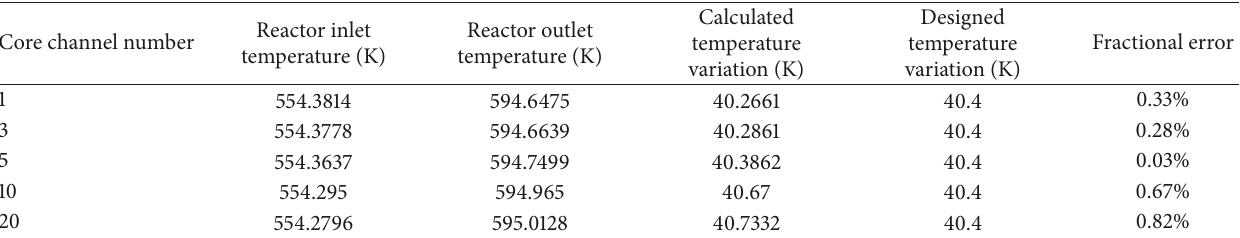
Table 3: The influence of core channel number on the coolant temperature variation.